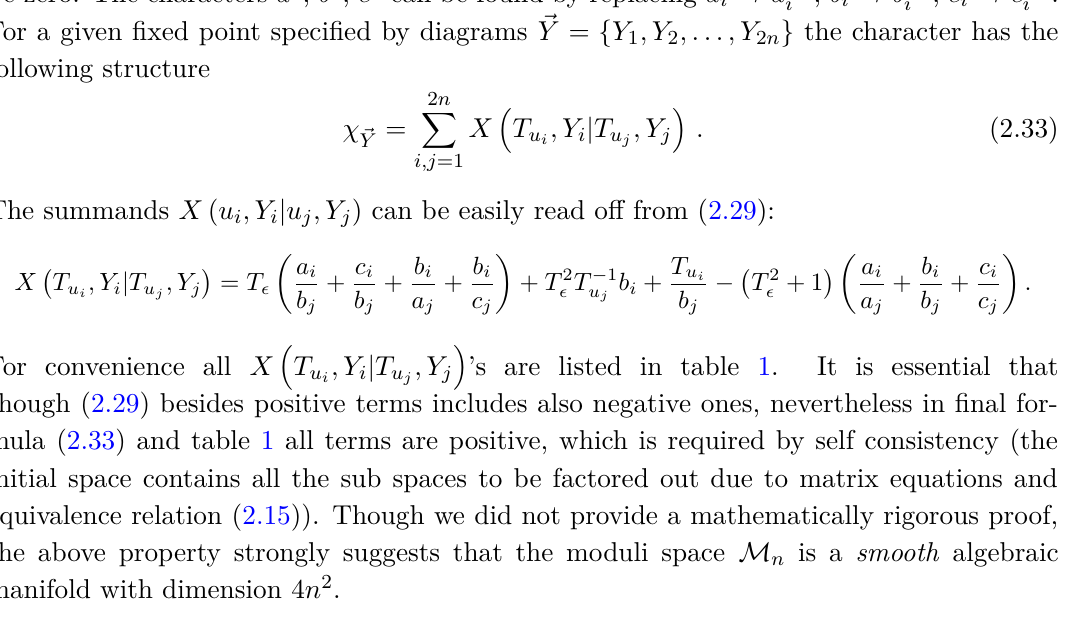
is suppressed for T u T − 1 u j i